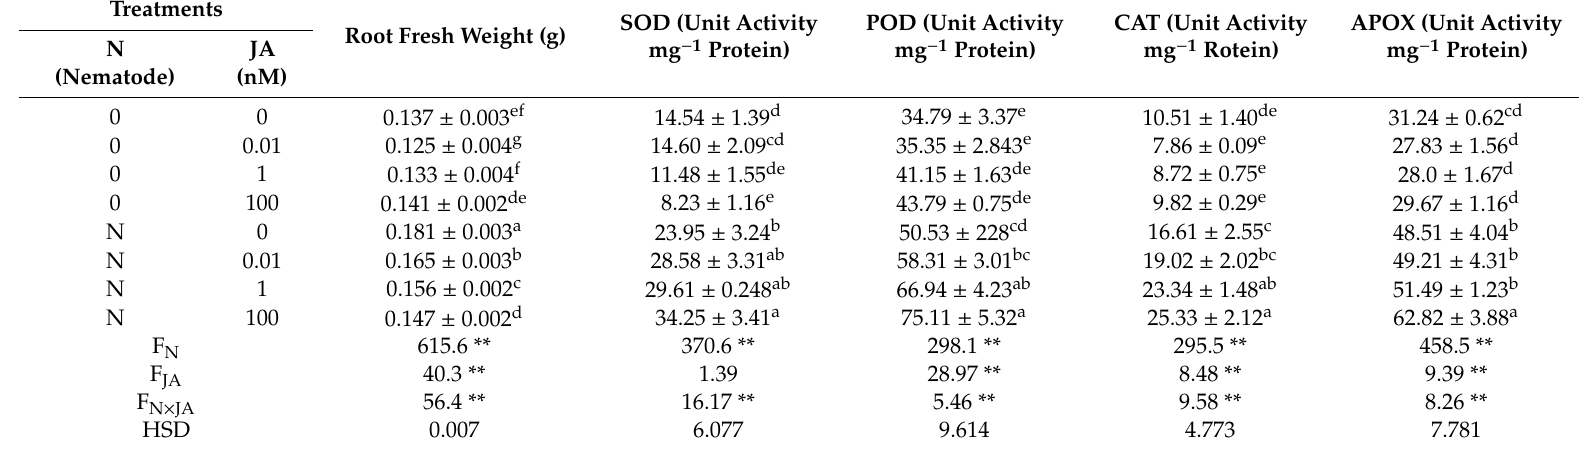
Table 2. E ff ect of seed soaking treatment of JA (0.01, 1 and 100 nM) on root fresh weight and the activities of SOD, POD, CAT, and APOX in tomato seedlings after seven days of nematode